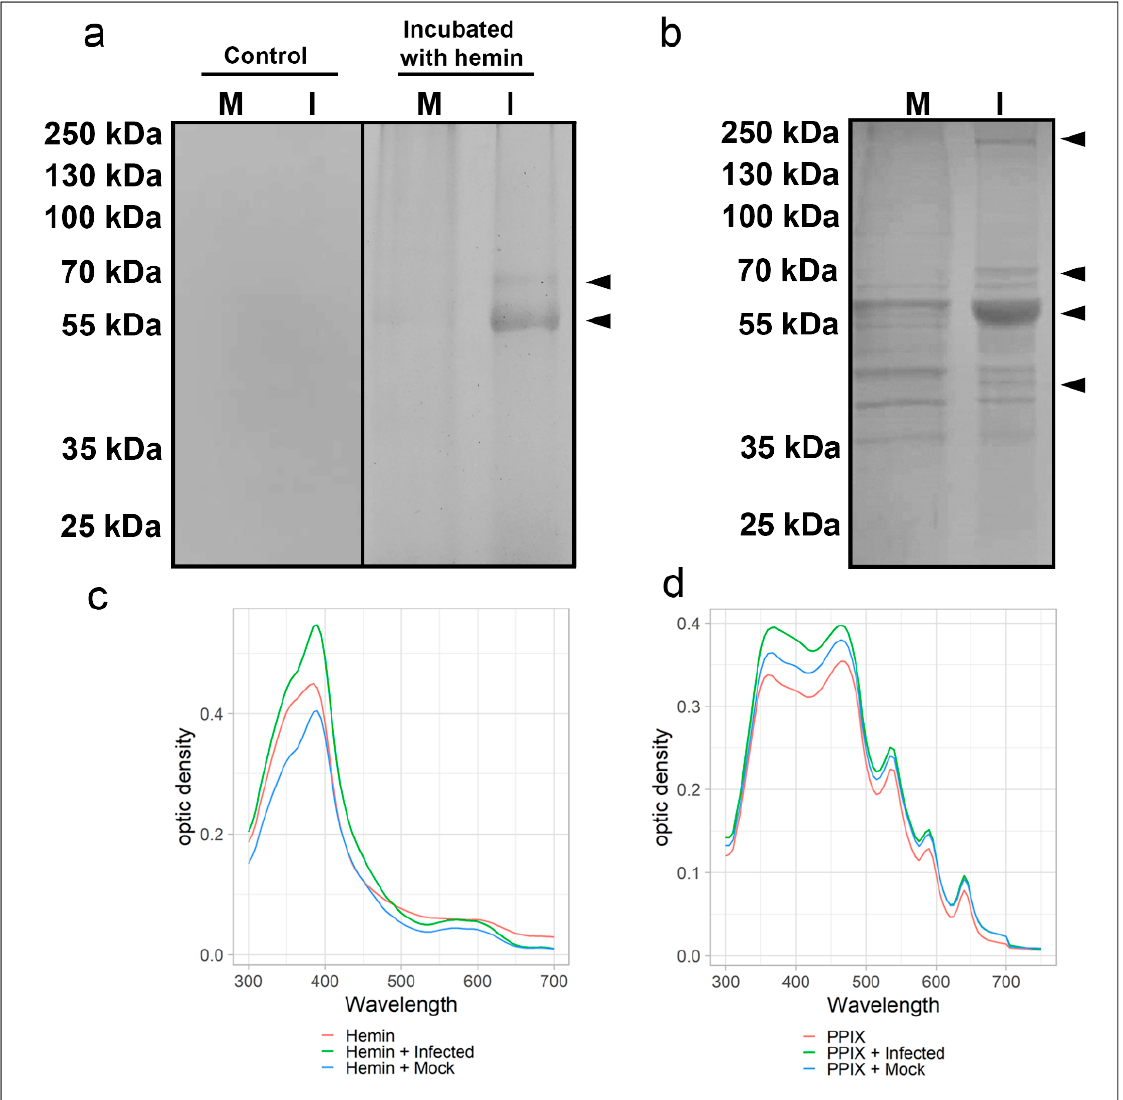
Figure 1. Heme-binding proteins in extracts from SARS-CoV-2 infected and non-infected Vero cells along with a spectroscopic binding analysis in solution. Total protein extracts (20 µ g) from virus-infected (I) and mock-infected (M) were: ( a ) incubated with 300 µ M of hemin for 1 h at 25 ◦ C, resolved by SDS-PAGE, renatured and exposed to TMB in-gel to reveal hemin or ( b ) resolved by SDS-PAGE, transferred to NM and incubated with hemin (2 µ M) for 1 h before revealing hemin-protein complexes by DAB. Arrowheads indicate bands of hemin-protein complexes. UV-visible spectra of hemin ( c ) alone (10 µ M, red) or in total protein extracts (20 µ g) of virus-infected Vero cells (green) and mock-infected cells (blue). UV-visible spectra of PpIX ( d ) alone (5 µ M, red) or in total protein extracts (20 µ g) of virus-infected Vero cells (green) and mock-infected cells (blue). Changes in the Soret peak and Q-bands are observable. Data are representative of two independent experiments. Source: data are provided as a source data file.